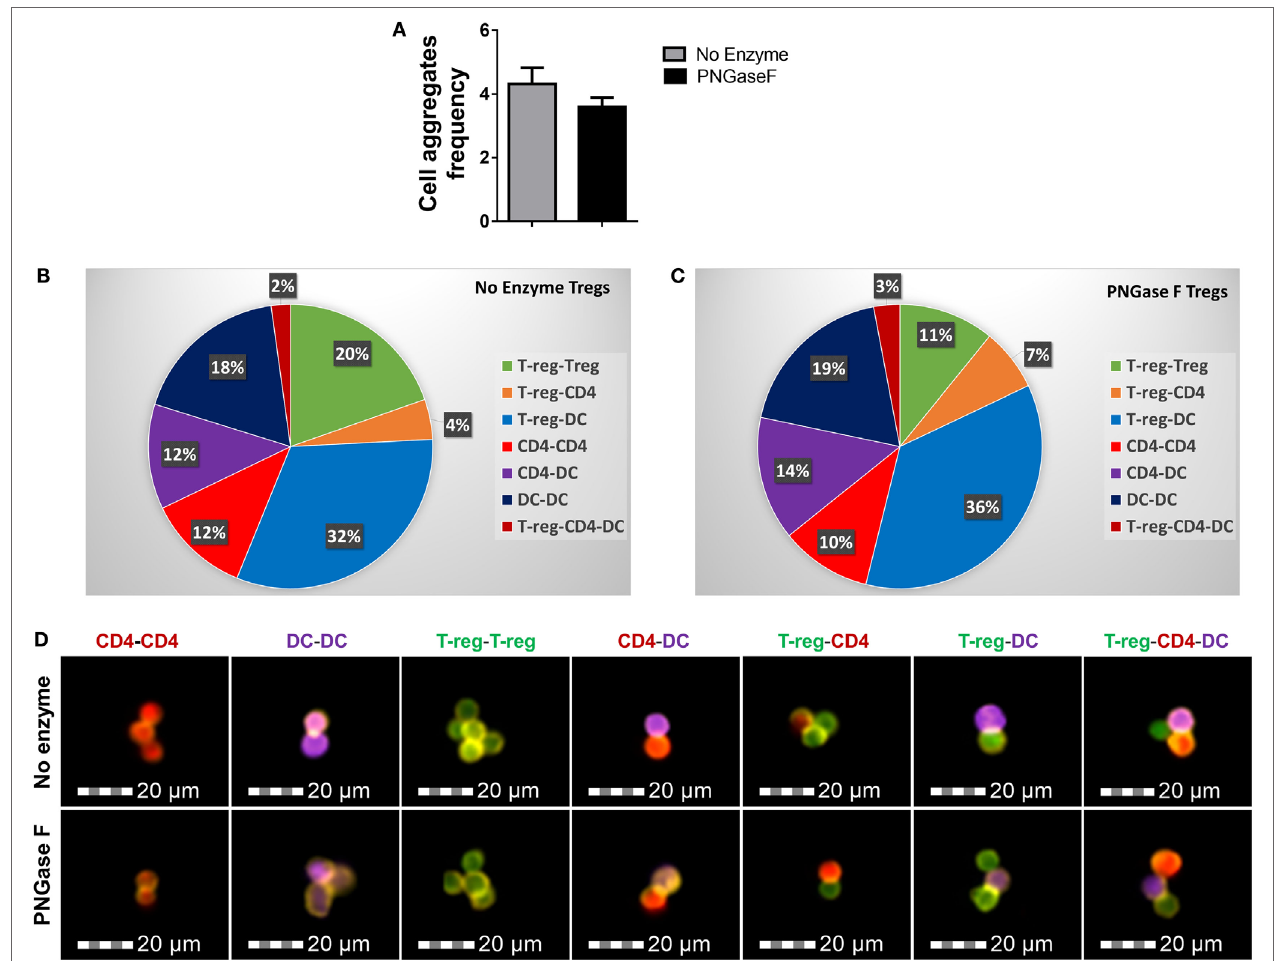
FigUre 9 | PNGase F treatment does not affect Treg ability to interact with other immune cells. (a–D) CD4 + responder T-cells were cocultured with CD11c + dendritic cells (DCs) and purified Treg (no enzyme or PNGase F-treated) at Treg: responder T-cell ratios of 1:2 for 8 h with anti-CD3 stimulation. Prior to coculture, Treg were fluorescently labeled with CellTrace ™ CFSE (CFSE), DCs with CellTrace ™ Violet (CTV) and CD4 + Responder T-cells with CellTrace ™ Far Red DDAO-SE (Far red). Immune cell interactions were quantified by flow cytometry. (a) Graph of the frequency of cell aggregates and (B,c) pie charts showing the proportionate frequencies of the different types of multi-cell aggregates present in the cocultures with (B) no enzyme and (c) PNGase F-treated Treg. (D) Imaging flow cytometric analysis of the immune cell interactions. Immunological synapse formation was identified by selective F-actin staining with Alexa Fluor ® 568 phalloidin (yellow stain). Representative examples of different types of immune cell aggregates present in the cocultures are presented for no enzyme and PNGase F-treated Treg cocultures. Data for (a–c) represent overall mean result from three identical experiments each with three technical replicates per condition ( n = 9). Statistical analysis was performed by permutation test with an unpaired design and no significant differences were